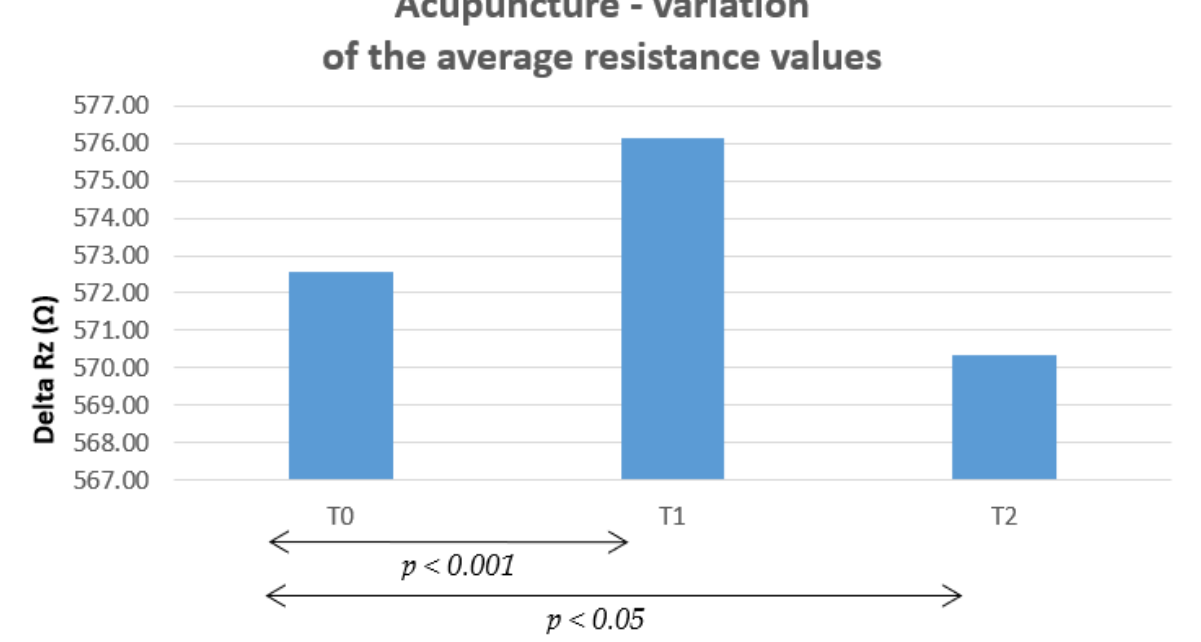
Figure 5. After acupuncture, averaged resistance increases at T1 and decreases at T2 with respect to T0 and T1, in the same selected points (both variations are statistically significant).